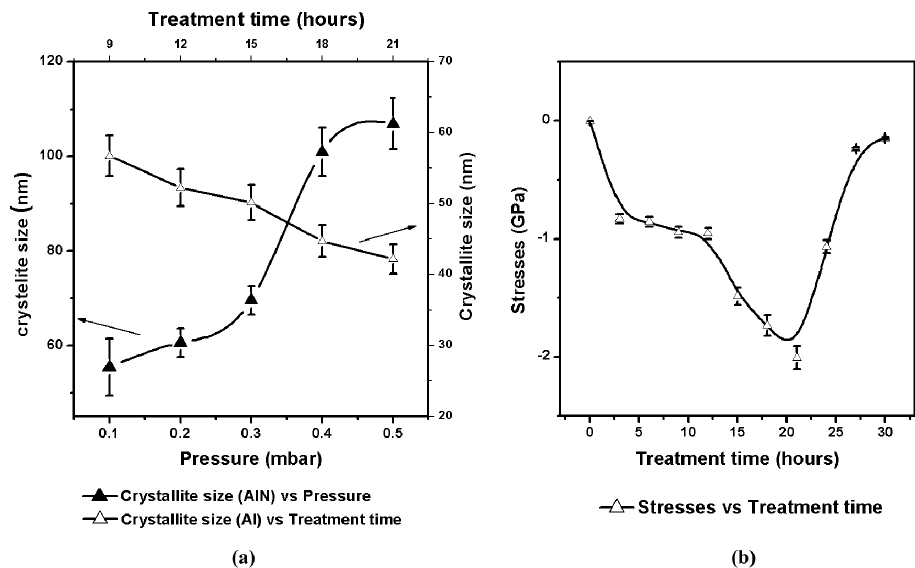
Figure 3. (a) Variation of crystallite size of AlN as a function of fill pressure (0.1, 0.2, 0.3, 0.4, 0.5 mbar) and treatment time (3, 6, 9…..30 hours), and (b) Variation of residual stresses in the substrate estimated from Al(111) plane as a function of treatment time (3, 6, 9, 12, 15, 18, 21, 24, 27 and 30 hours); all samples treated at 0.5 mbar fill